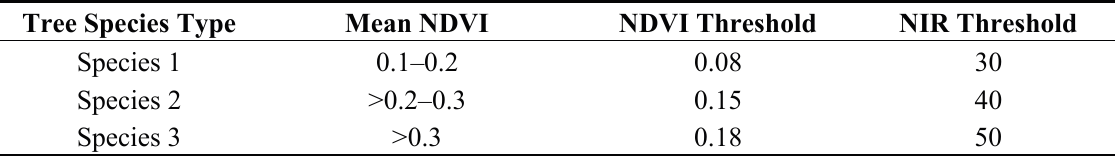
Table 5. Classification of seeds to tree species type and region-growing thresholds established from the training